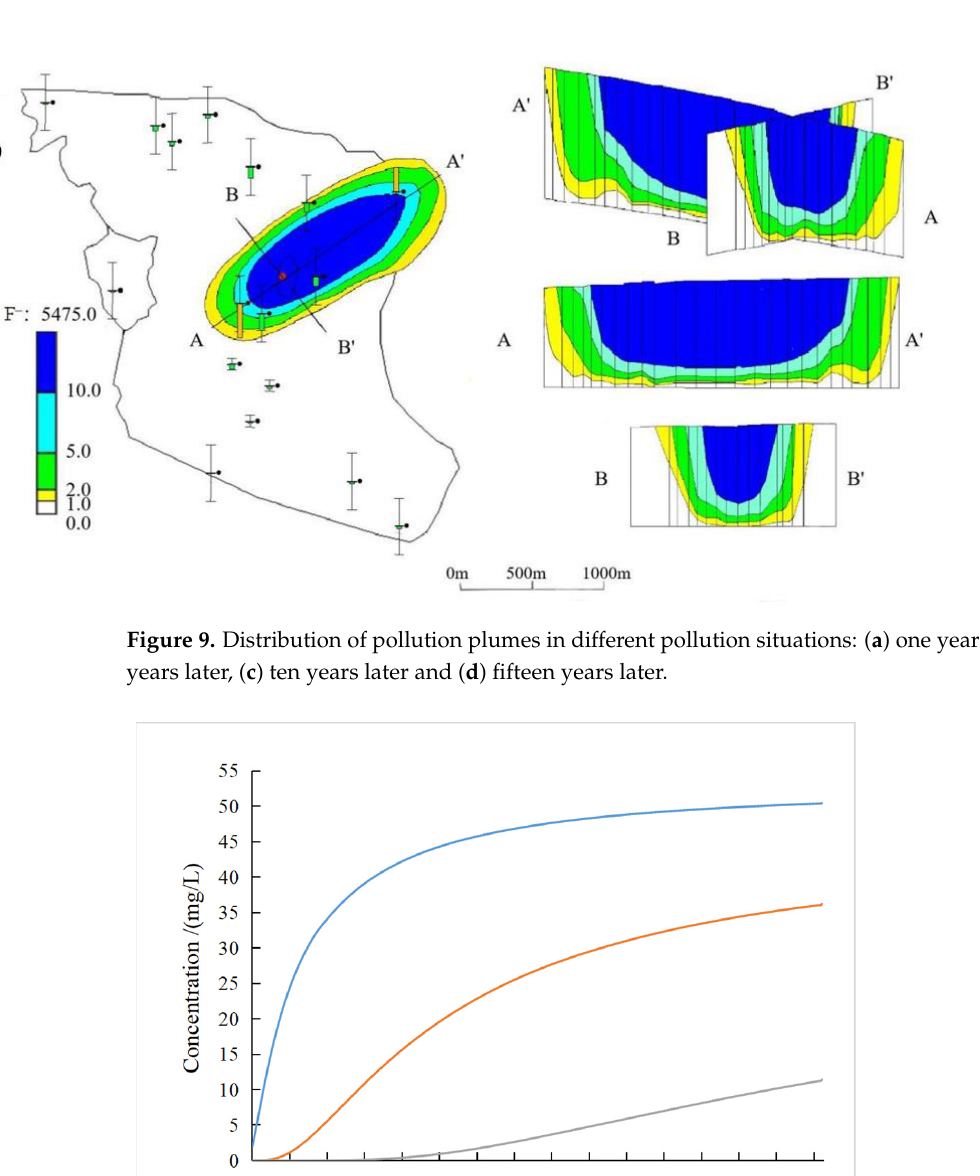
Figure 9. Distribution of pollution plumes in different pollution situations: ( a ) one year later, ( b ) five years later, ( c ) ten years later and ( d ) fifteen years later.